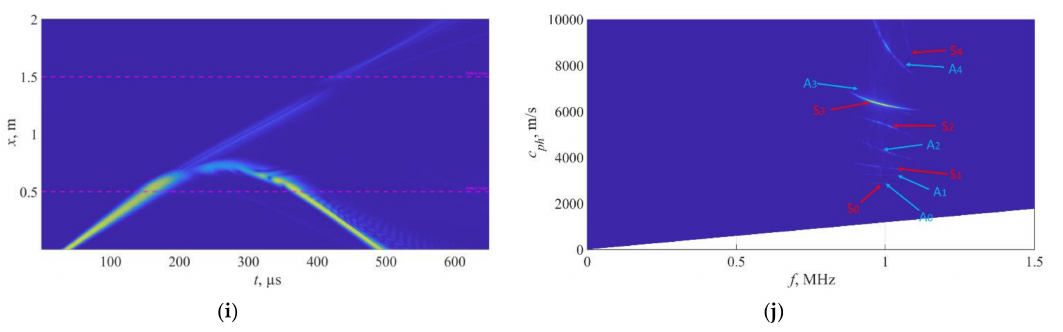
Figure 20. The B-scans and reconstructed phase velocities in case of corrosion-like defects: ( a , b ) localized defect of 30% wall thickness; ( c , d ) localized defect of 50% wall thickness; ( e , f ) pitting defect of 30% wall thickness; ( g , h ) pitting defect of 50% wall thickness; ( i , j ) uniform defect of 50% wall